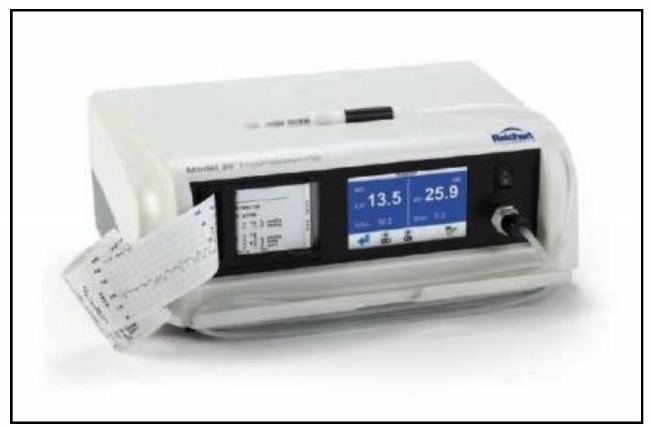
Figure 9. Pneumotonometer.